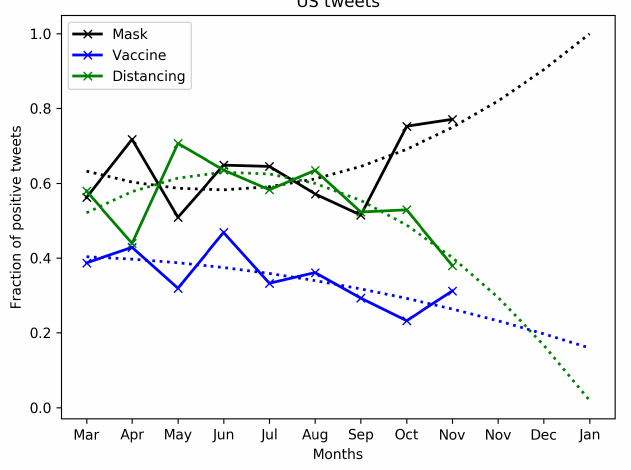
Figure 6. Evolution of public sentiment in world tweets about COVID-19 keywords, vaccine, mask, and distancing over time.